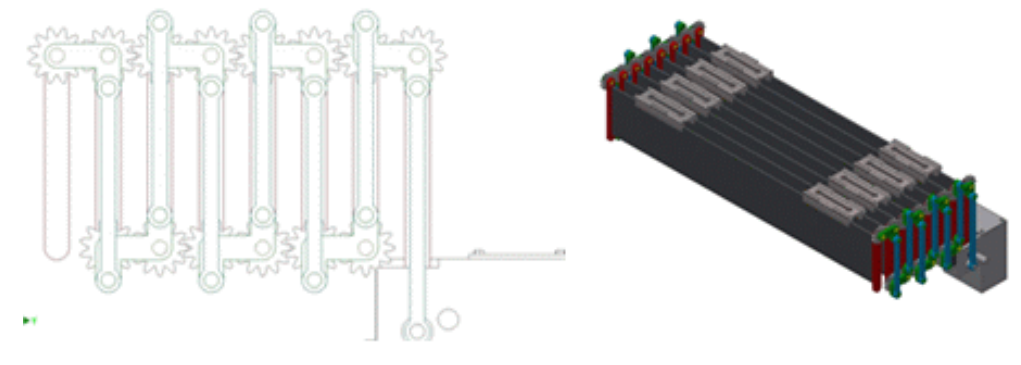
Figure 3. Folding solar module.